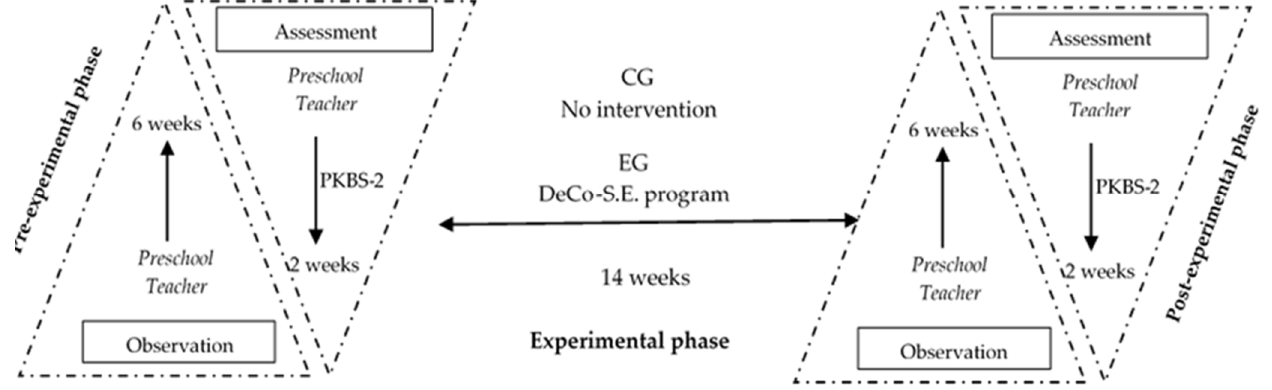
Figure 1. The diagram of the three stages of the research.